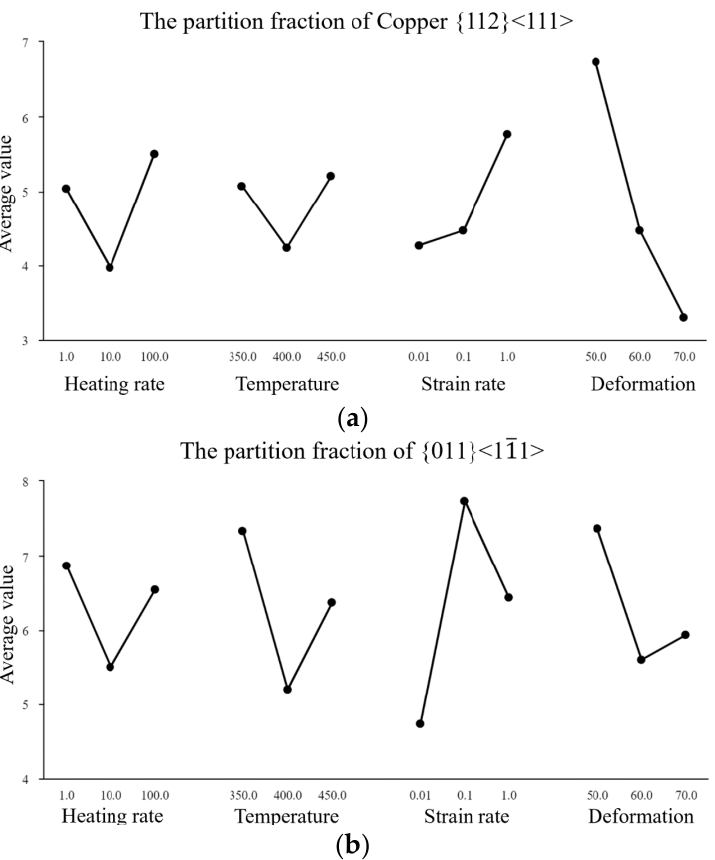
Figure 10. Sensitivity analysis of textures to hot compression deformation parameters. ( a ) Cooper {112} <111>; ( b ) {011} <1 1̅ 1>.